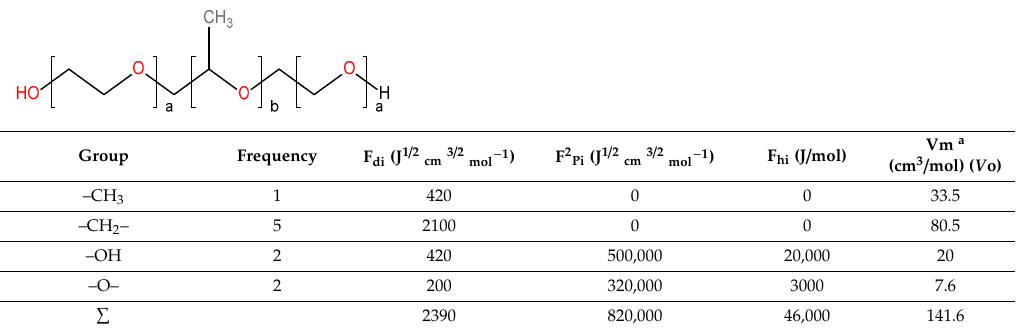
Table 6. Calculated HSPs of and drug–polymer interaction factor for drug and polymers.